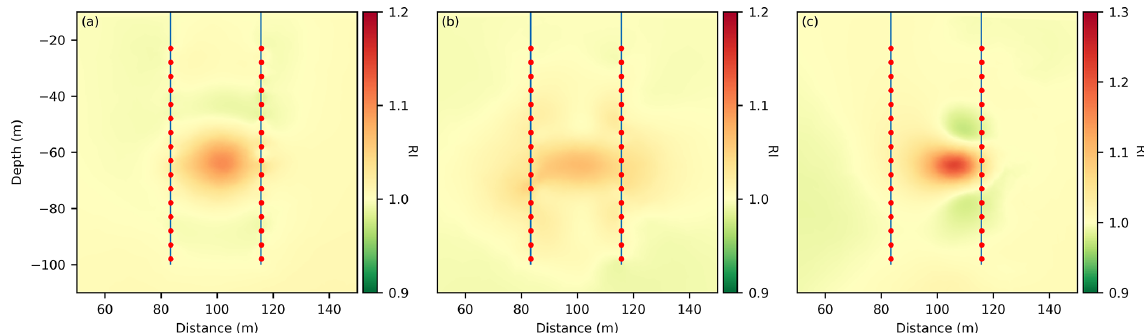
Figure 7. Inversion results using the field schedules on the pre-experiment model for 1.7t of CO 2 injection. (a) Geometry-optimized AM– BN schedule. (b) Geometry optimized AB–MN schedule. (c) Sensitivity optimized schedule. Note the adjusted color scale for (c) . The Chi 2 misfits for the inverion result containning the CO 2 plume are (a) 0.041, (b) 0.023, (c) 0.315.